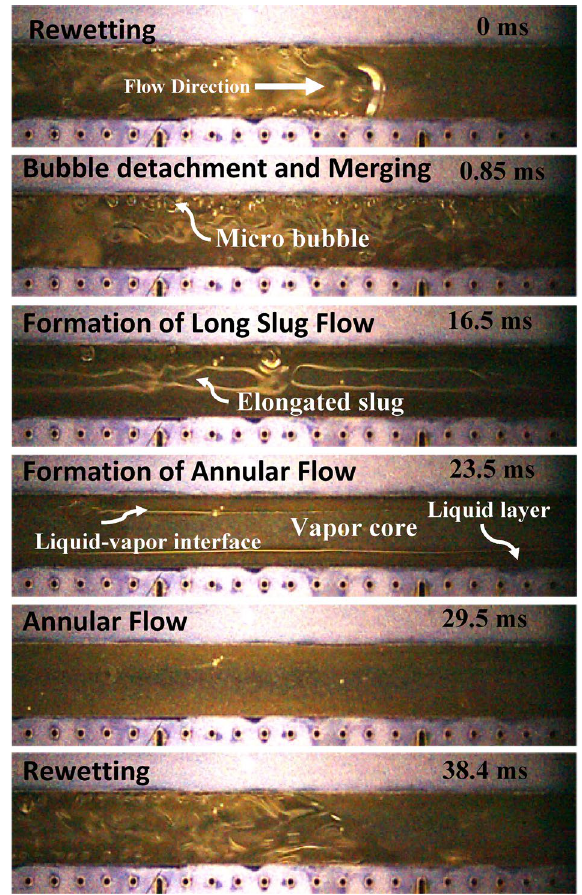
Figure 6. Flow pattern transitions in flow boiling SiNW microchannels at mass flux, 400 kg/m 2 s and heat flux, 30 W/cm 2 .